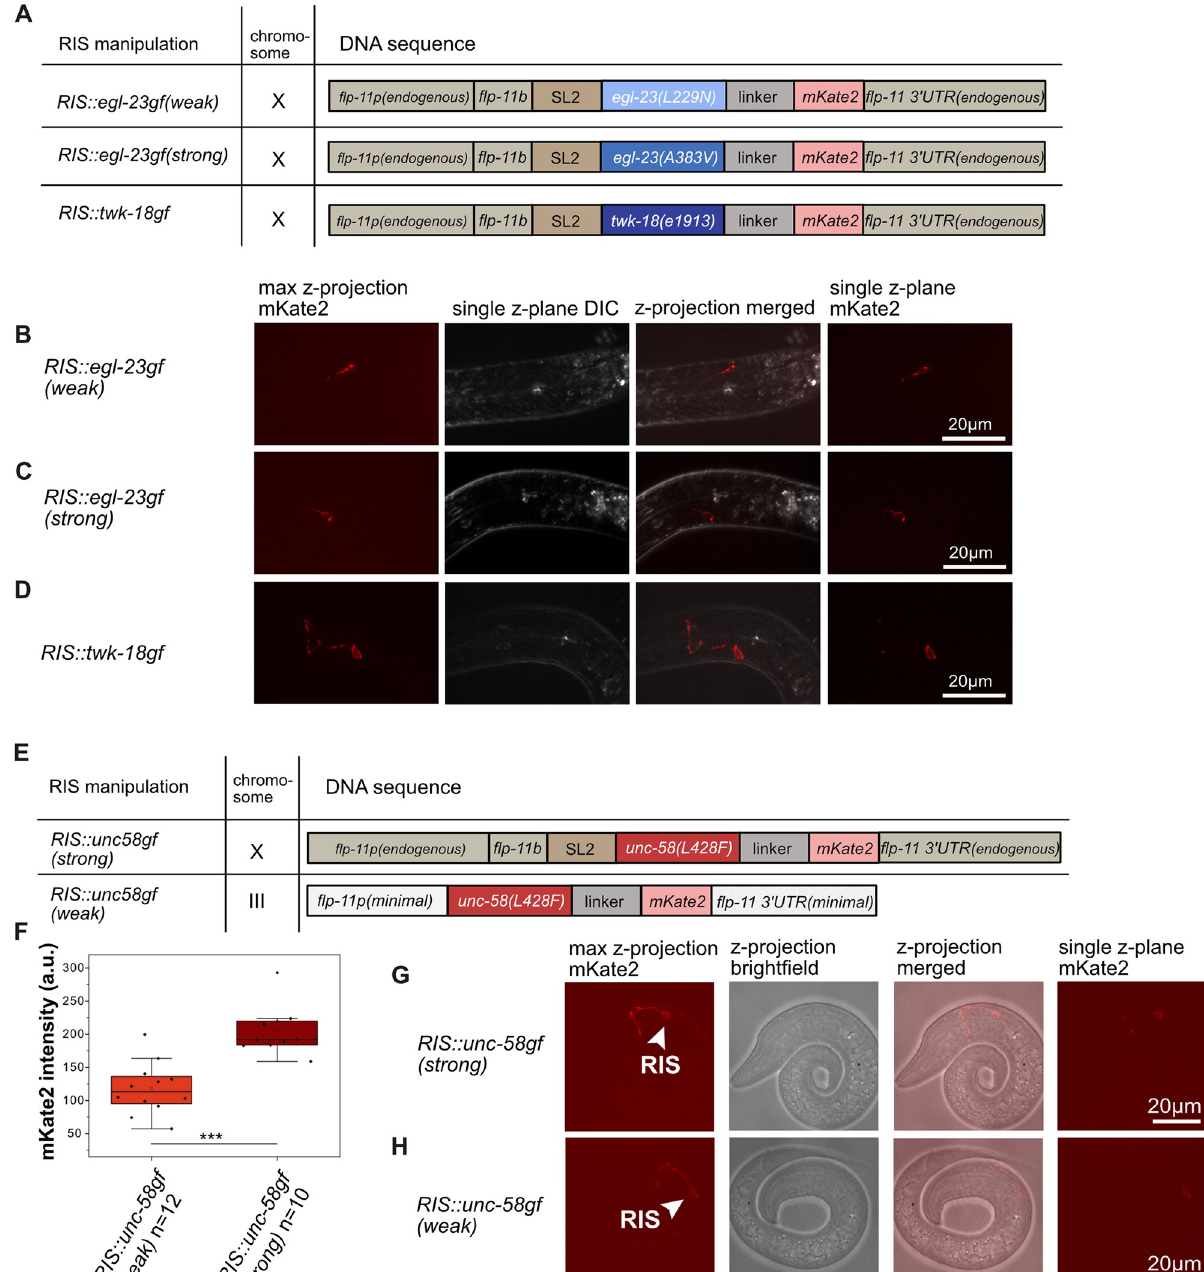
Fig 1. Strains expressing ion channel mutants in RIS. A) Scheme of the genetic design of the different RIS potassium channel mutant transgenes. B-D) Localization and expression of mKate2, which is translationally fused to the ion channels, in the different inactivation strains. E) Schematic representation of the genetic design of the RIS sodium channel mutant transgenes. F) Quantification of the expression levels of UNC-58gf::mKate2 in the two RIS overactivation strains. ��� p < 0.001, Welch test. G) Localization and expression of the strong overactivation strain ( RIS :: unc-58gf(strong) ). H) Localization and expression of the weak overactivation strain ( RIS :: unc-58gf(weak) ).